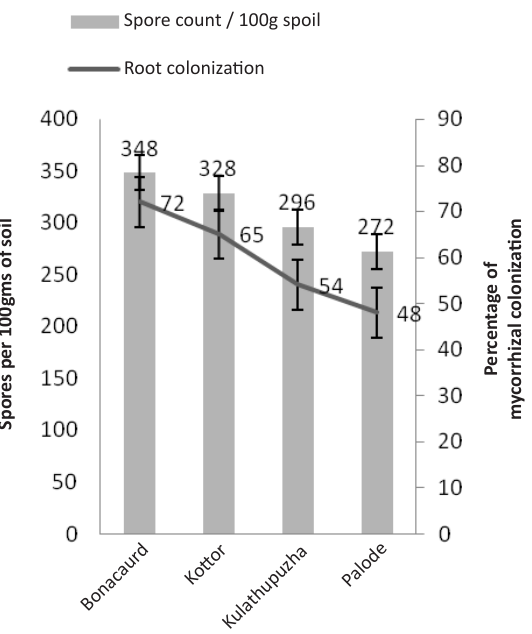
Figure 1. Arbuscular mycorrhizal fungal root colonization and spore count per 100g soil of different habitats of Ochlandra